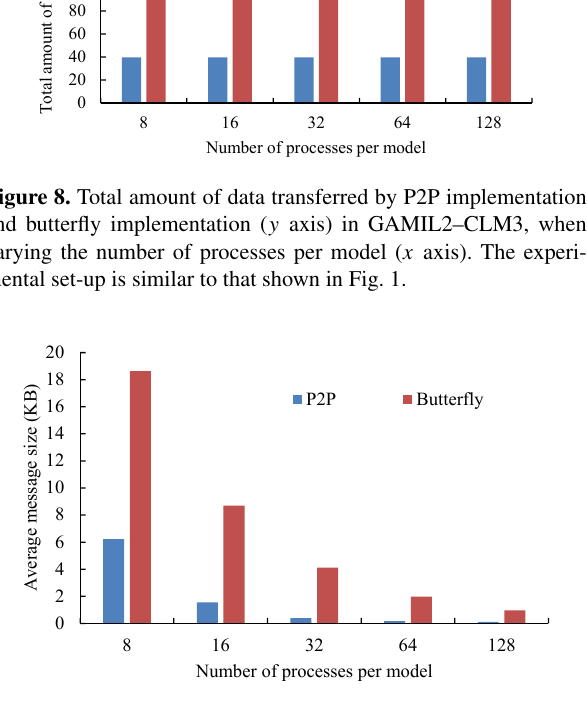
Figure 9. Average message size transferred by P2P implementation and butterfly implementation ( y axis) in GAMIL2–CLM3, when varying the number of processes per model ( x axis). The experi- mental set-up is similar to that shown in Fig. 1.